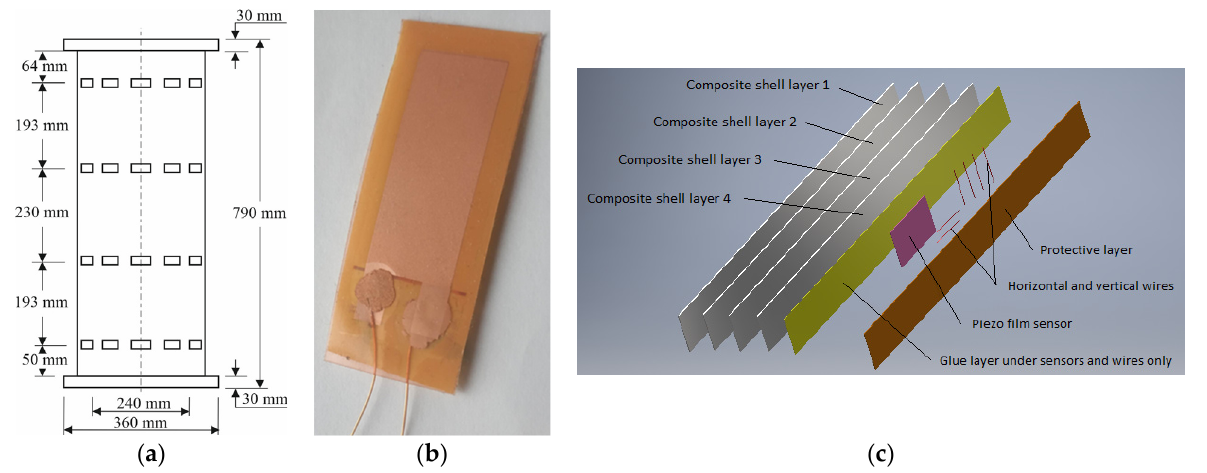
Figure 1. The specimen: ( a ) design of cylindrical shell and location of the piezoelectric sensors; ( b ) piezoelectric sensor; ( c ) exploded view for cylinder wall element.